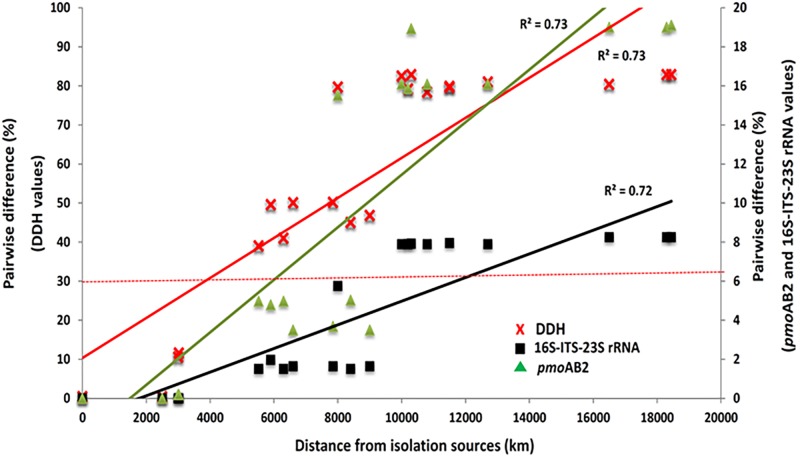
Scatter plot of pairwise nucleotide differences of the 16S-ITS-23S rRNA (black squares) and pmoAB2 (green triangles) gene sequences of the Methylacidiphilum spp. isolates and pairwise genome sequence differences (red crosses) based on in silico DNA-DNA hybridization (DDH) values. The left y-axis indicates genomic differences while the right y-axis indicates 16S-ITS-23S rRNA and pmoAB2 differences. The x-axis indicates the geographic distance between the isolation source for each pairwise strain comparison. A stippled demarcation line for DDH threshold for species separation (>30% difference or 70% > similarity) is included.